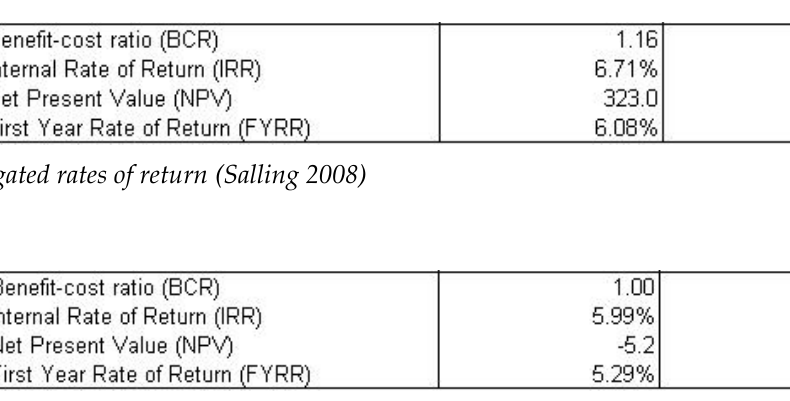
Figure 8. Aggregated rates of return including Optimism Bias uplifts (Salling